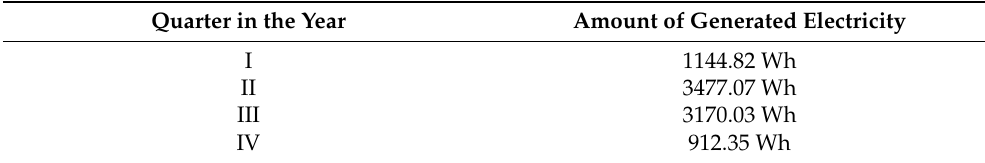
Table 2. The amount of electricity generated in each quarter of the year.